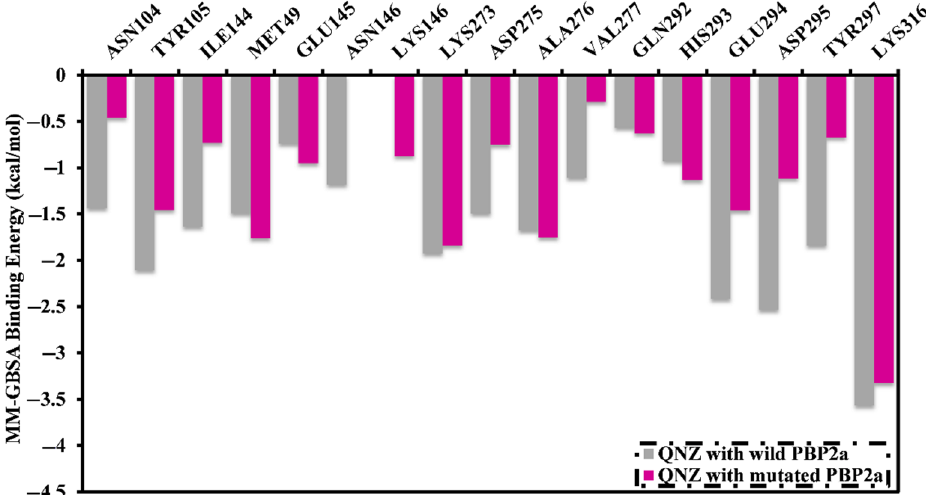
Figure 2. Energy contributions (in kcal/mol) for PBP2a amino acid residues to the total MM-GBSA binding energies of QNZ in complex with wild and mutated PBP2a allosteric site in acidic medium.